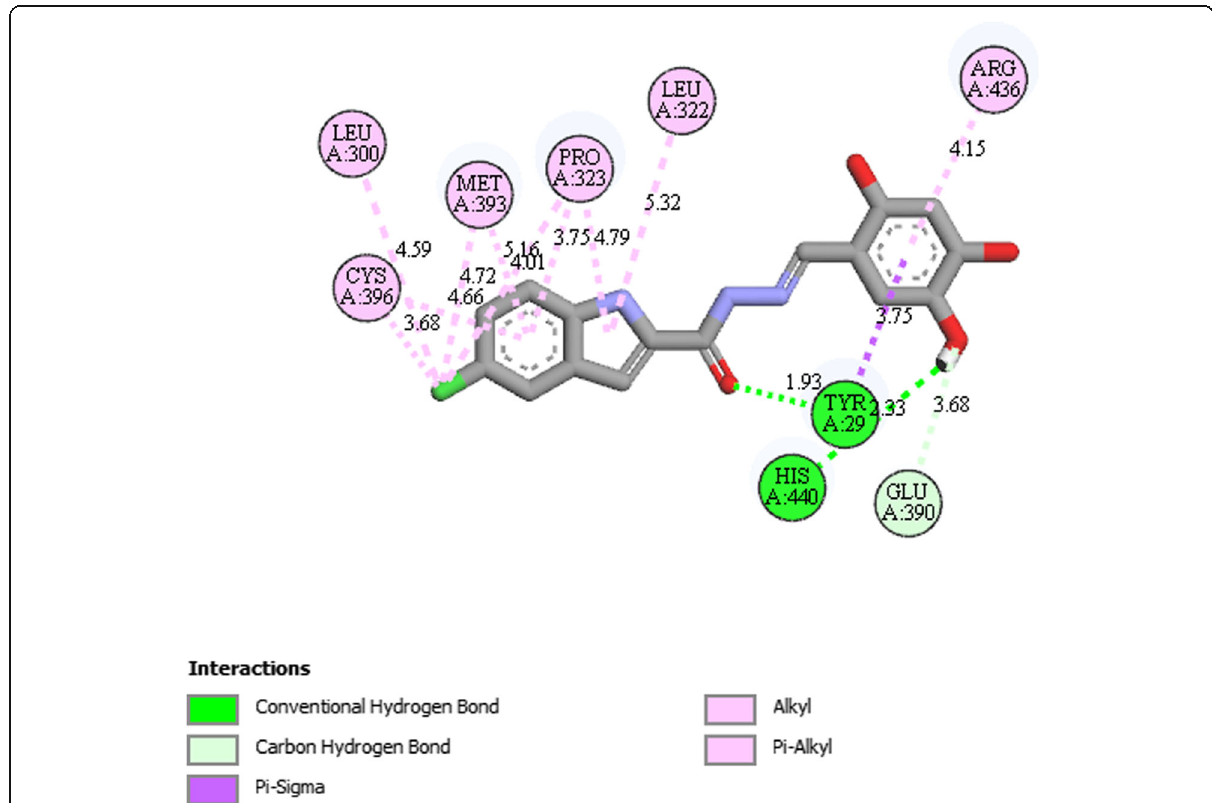
Fig. 5 The 2D structure of visualized ligand-receptor